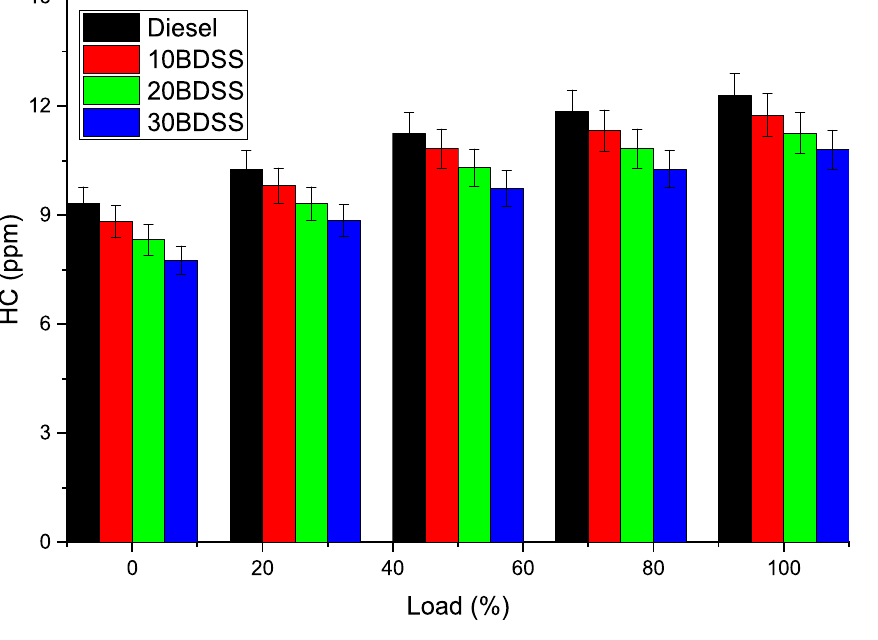
Figure 10. Influence of biodiesel blends in HC